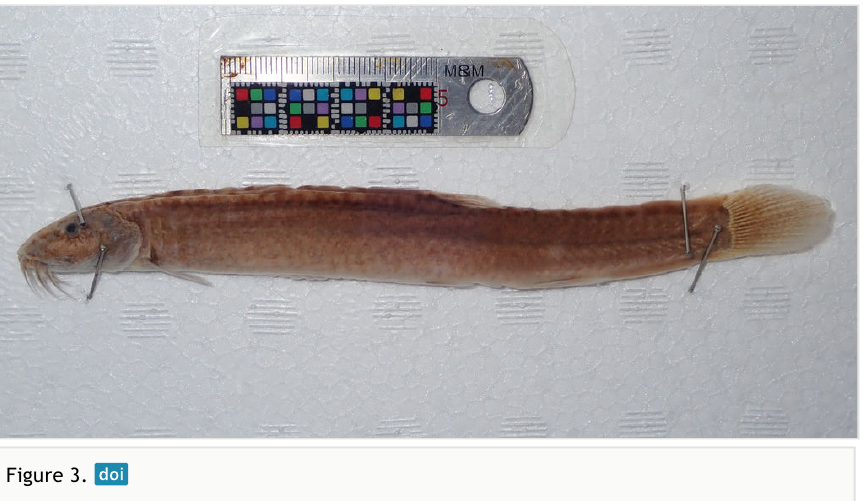
An old specimen of Misgurnus anguillicaudatus (Jindai-dojyô) (MPMQ-JJ1), an uncertain local clade that is already extinct.